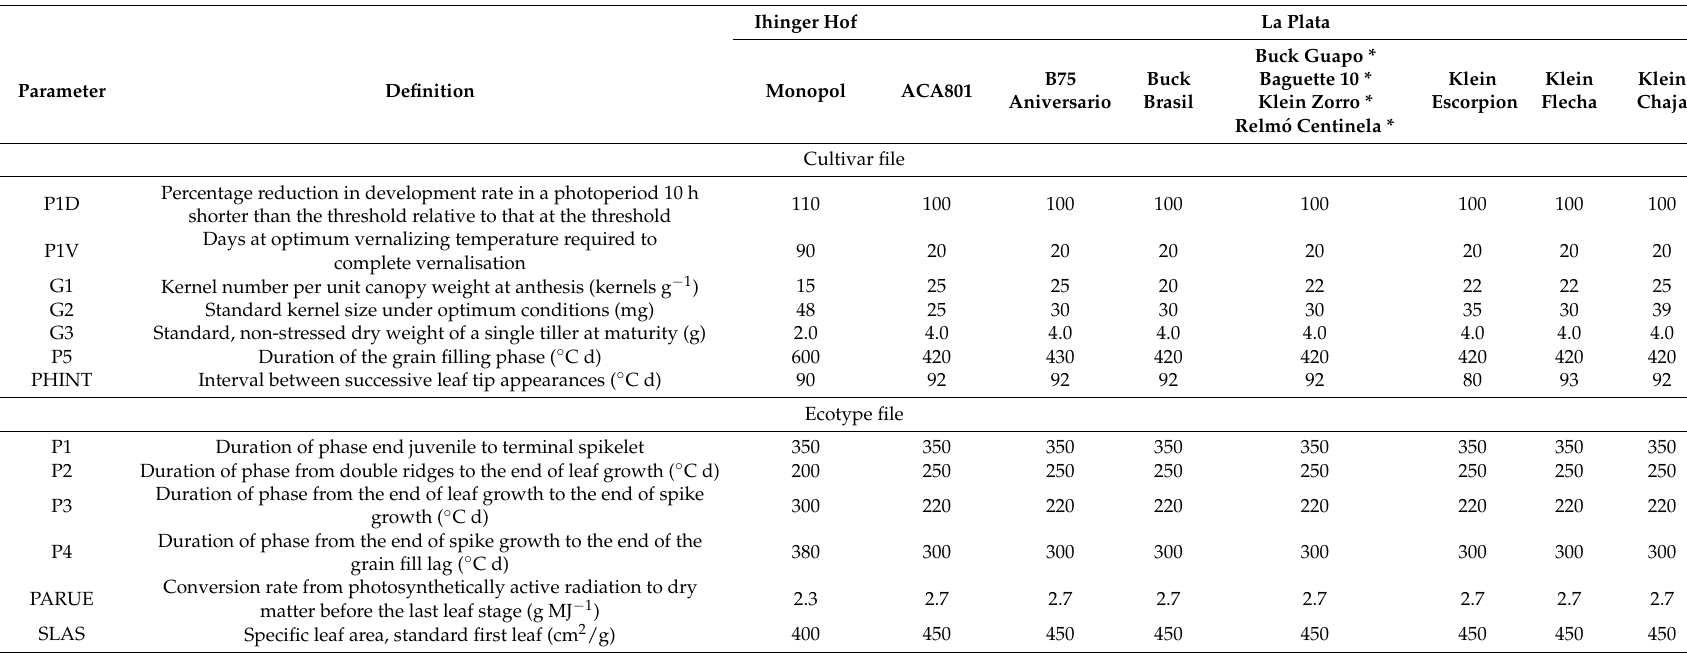
* various wheat cultivars with the same cultivar